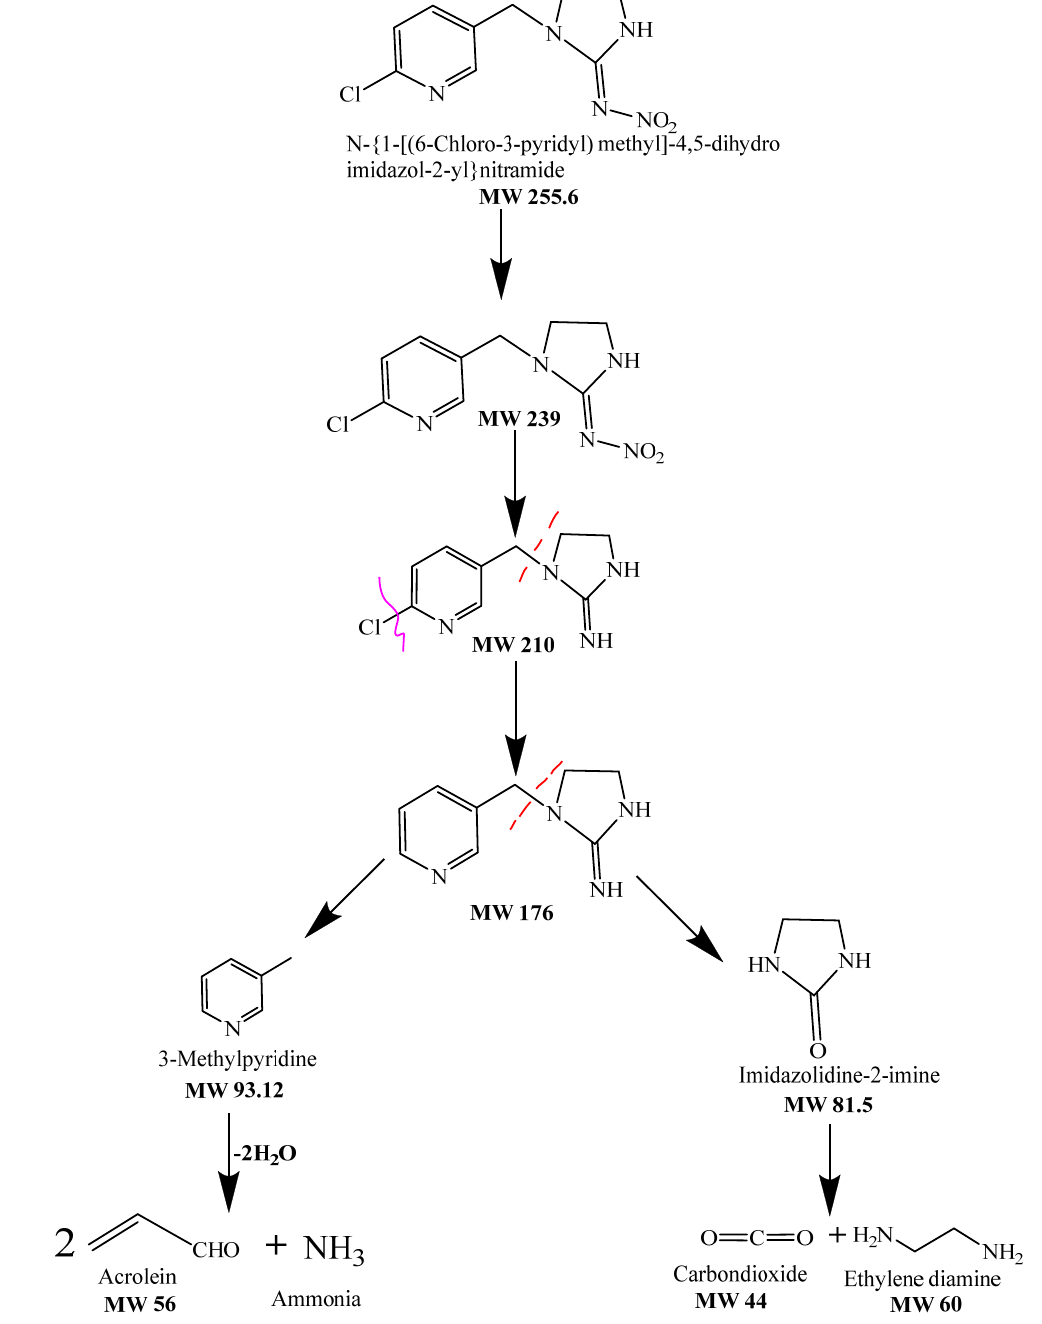
Figure 14. Degradation mechanism of imidacloprid degradation using basic prewetted nanocalcite @